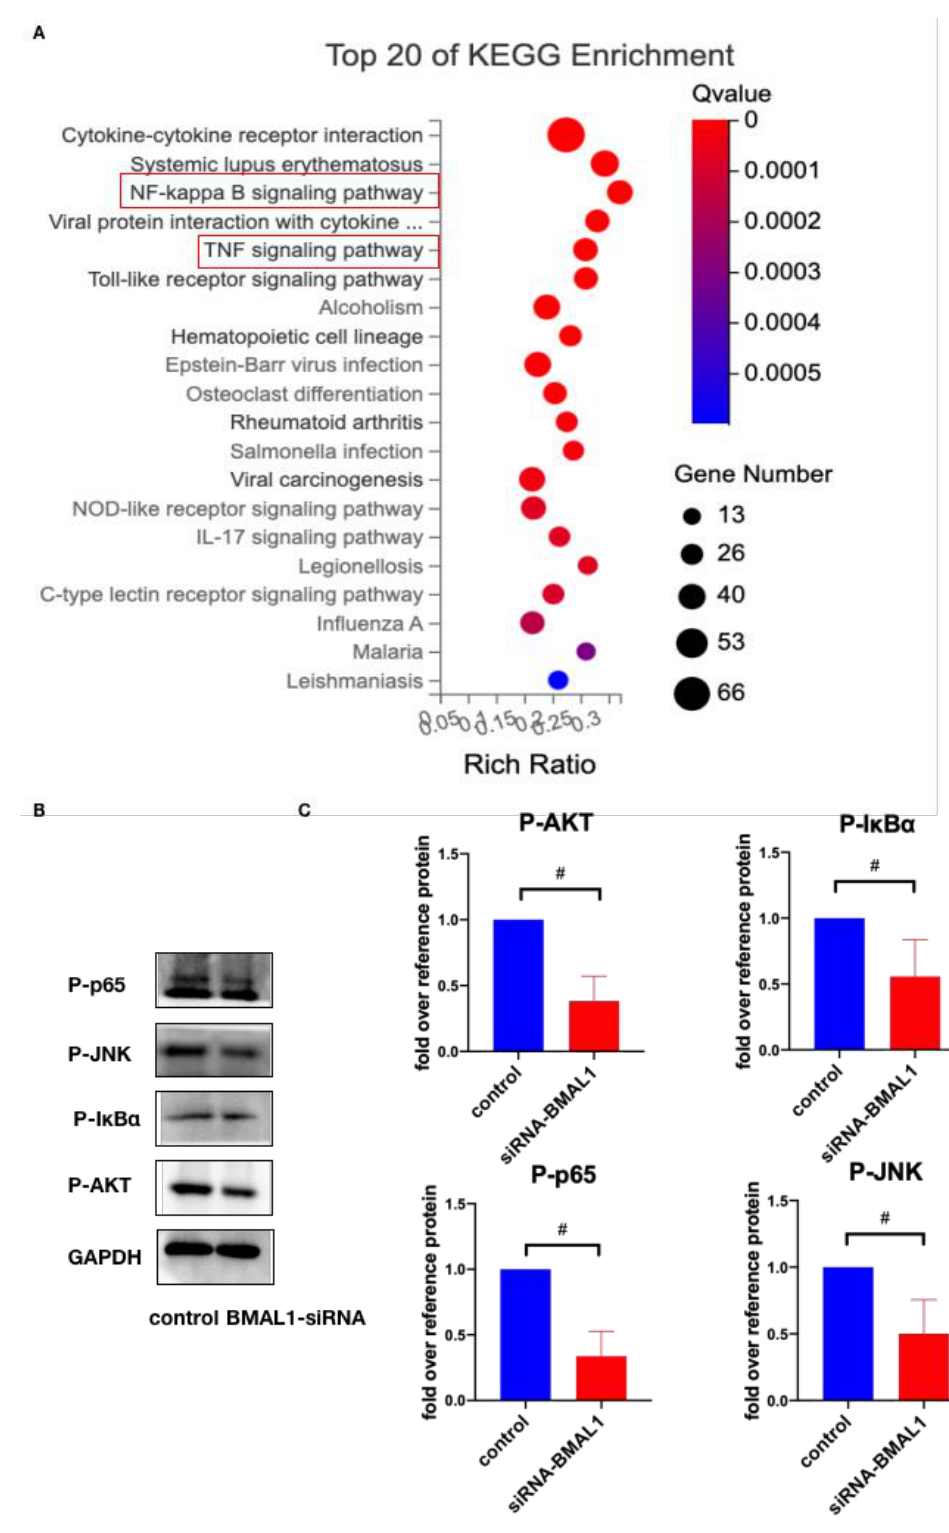
Figure 6. BMAL1 promotes HVICs’ osteogenic differentiation through NF- κ B/AKT/MAPK